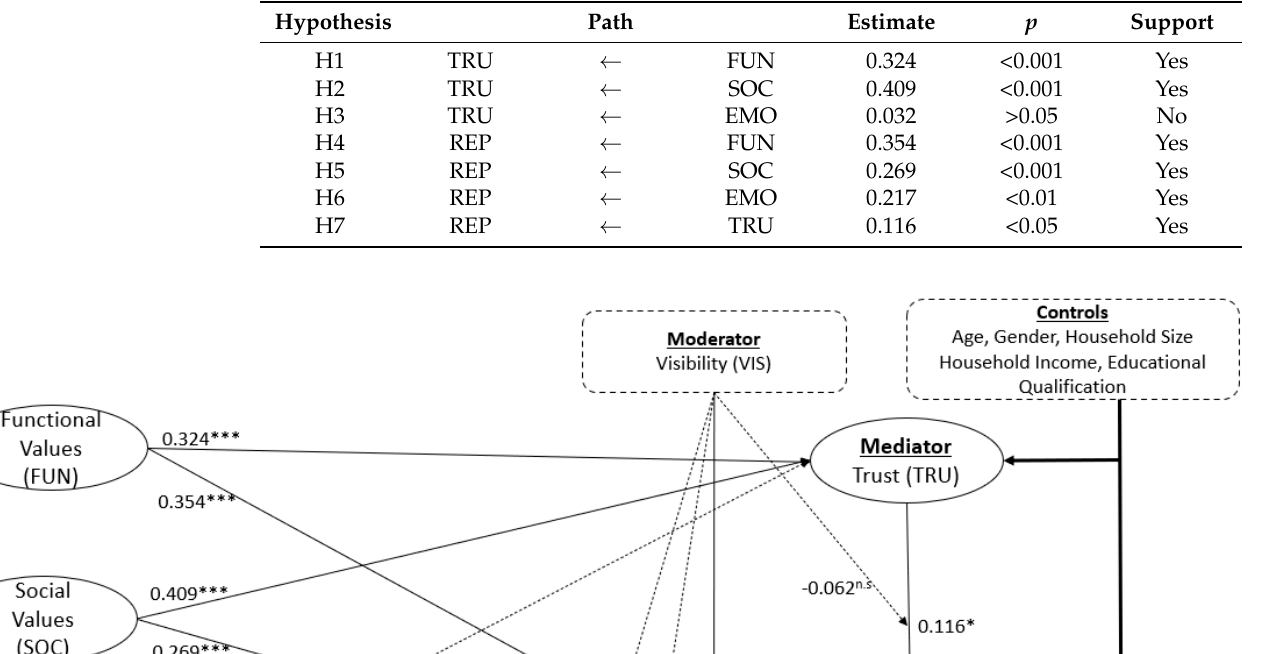
Table 4. Results of Hypothesis.